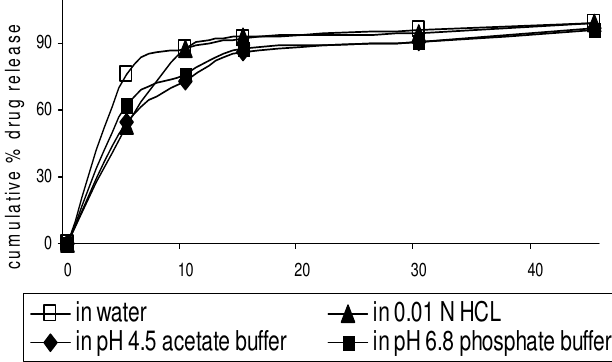
Figure 3. Drug release rate of Zidovudine tablets 300 mg in various pH